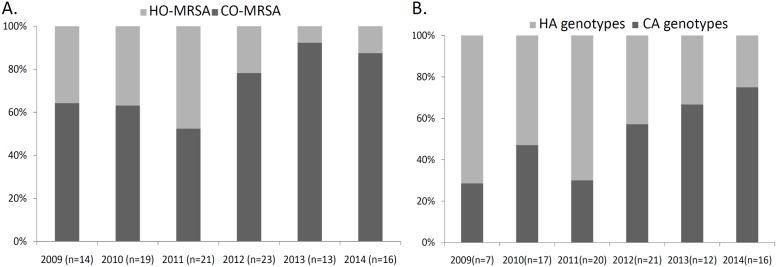
(A) The proportions of healthcare-associated community onset (CO)- and healthcare-associated hospital onset (HO)-MRSA bacteremia in hemodialysis cases in a Taiwanese medical center from 2009 to 2014. A linear trend toward an increasing proportion of CO-MRSA during 2009 to 2014 was observed (R2 = 0.662, p = 0.062). (B) The proportions of CA genotypes (SCCmec type IV, V) and HA genotypes (SCCmec type I, II or III strains) in hemodialysis cases in a Taiwanese medical center from 2009 to 2014. A linear trend toward an increasing proportion of CA genotypes during 2009 to 2014 was observed (R2 = 0.791, p = 0.018).